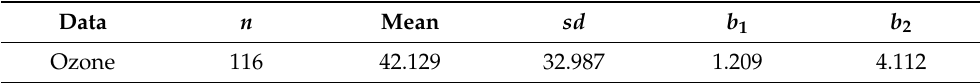
Table 3. Descriptive statistics of ozone concentration level measurement